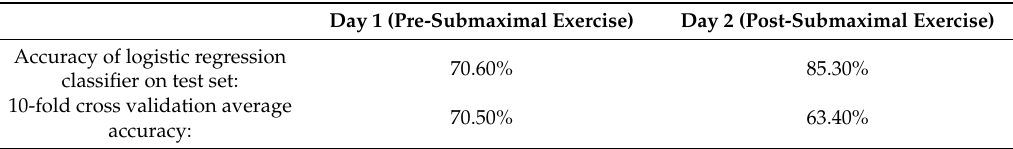
Table 5. Model accuracy on Days 1 (pre-submaximal exercise) and 2 (post submaximal exercise) and cross validation results. These results indicate that the Day 2 model, or model created after exercise, had a higher degree of accuracy that the Day 1 model. Although both were able to di ff erentiate GWI from an SC, the Day 2 model performed slightly